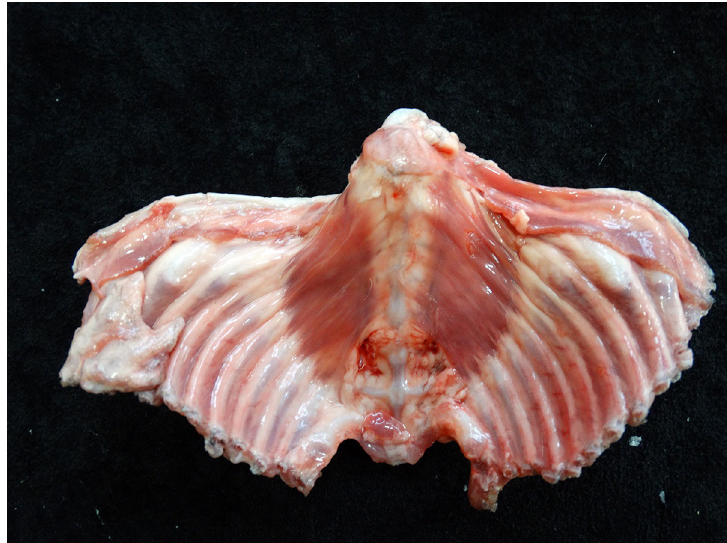
Figura 4. Má formação do esterno; costelas sinuosas e excessivamente encurvadas e